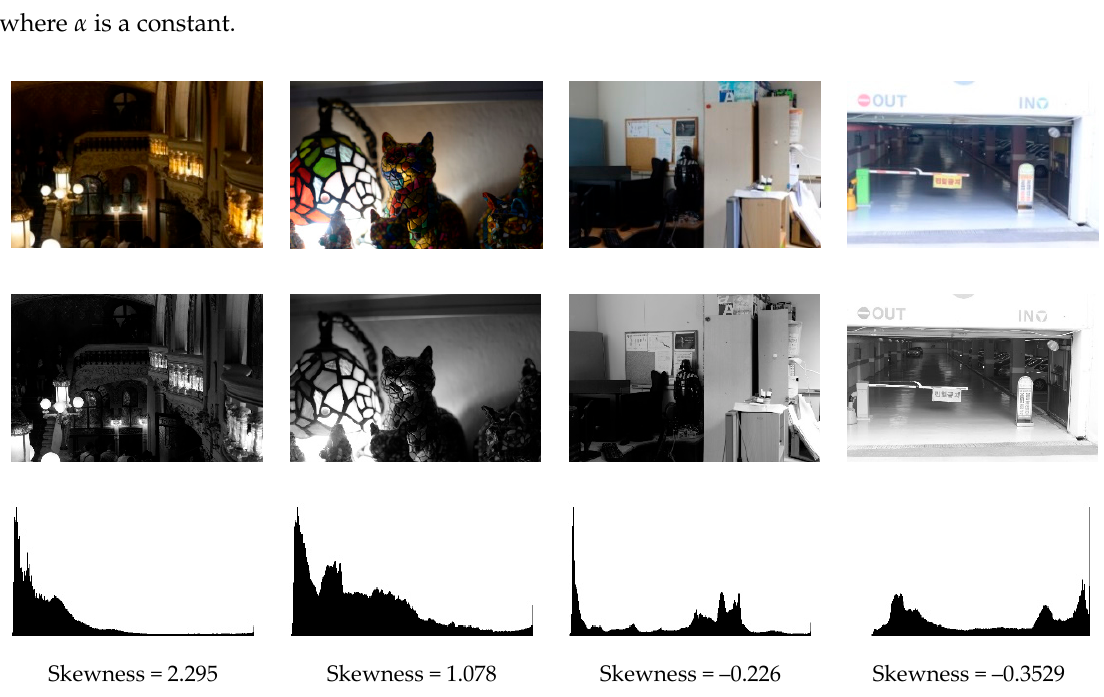
Figure 2. Examples of histogram and skewness: (from top to bottom) low-light color image, luminance image, and histogram and skewness of luminance image.